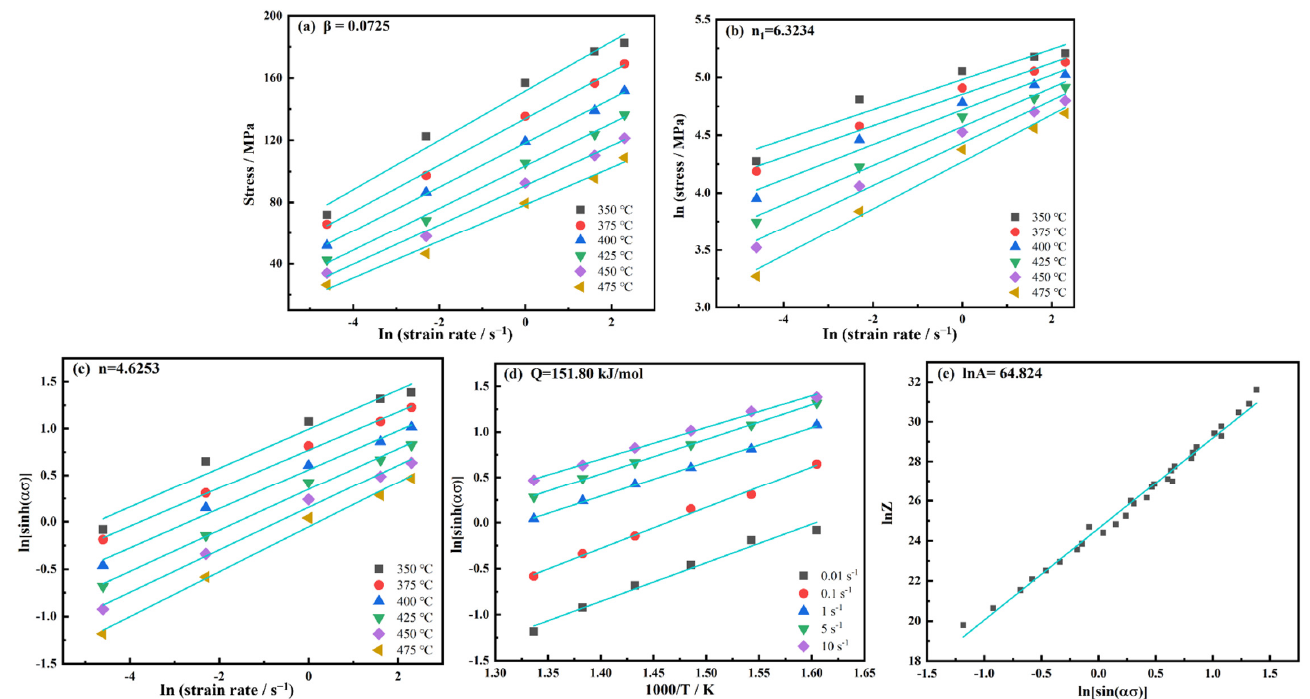
. . ε − σ ; ( b ) ln ε − ln σ ;